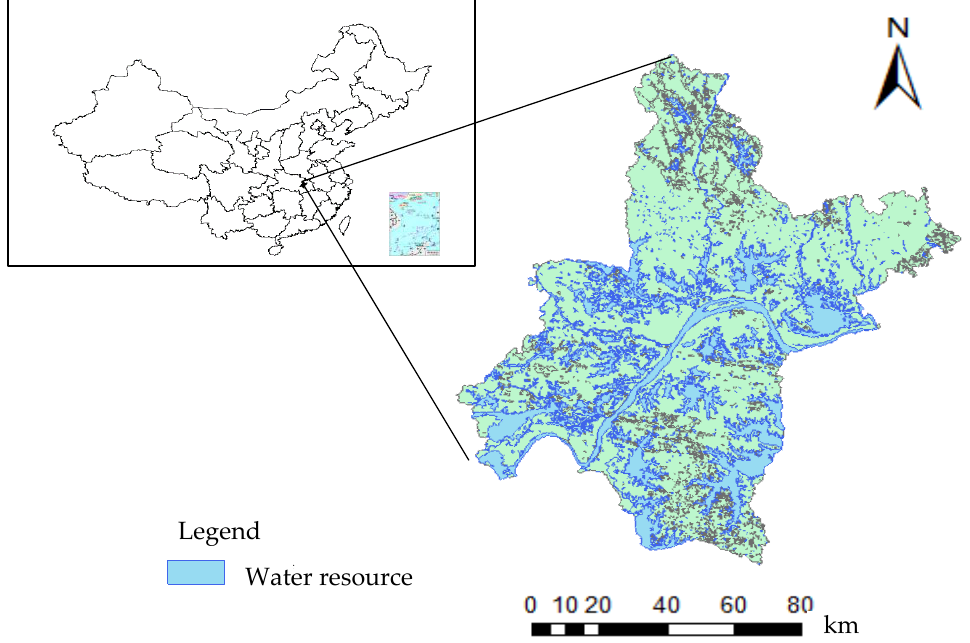
Figure 1. Water resource distribution map of Wuhan City.